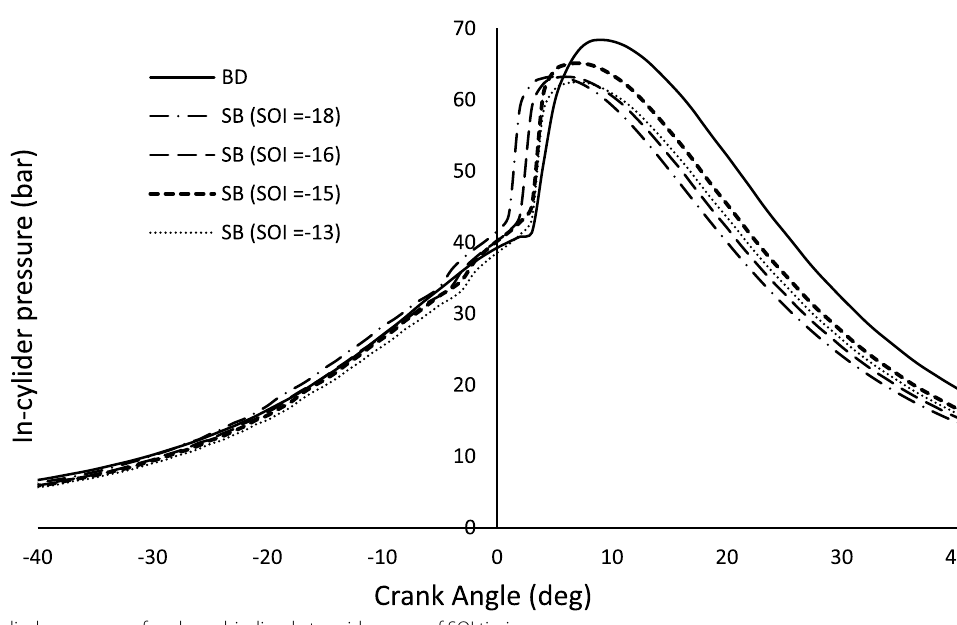
Fig. 18 In‑cylinder pressure of soybean biodiesel at a wide range of SOI timings